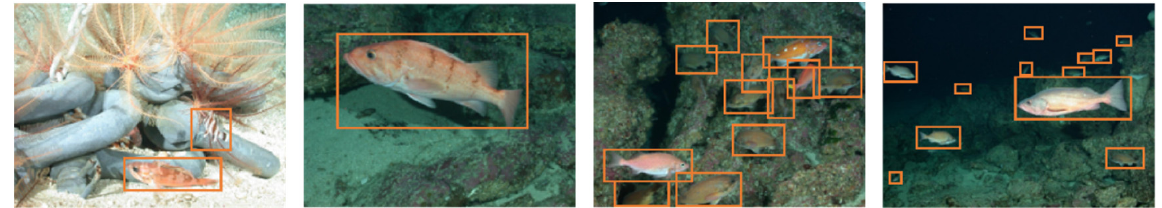
Figure 3. Partial sample of the dataset. The orange box represents the detection